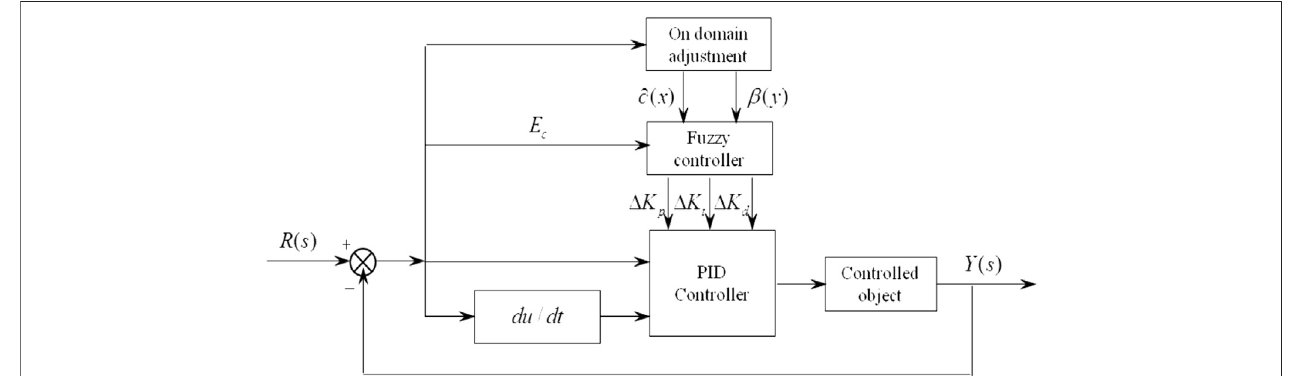
FIGURE 12 | The domain fuzzy PID bias controller block diagram.